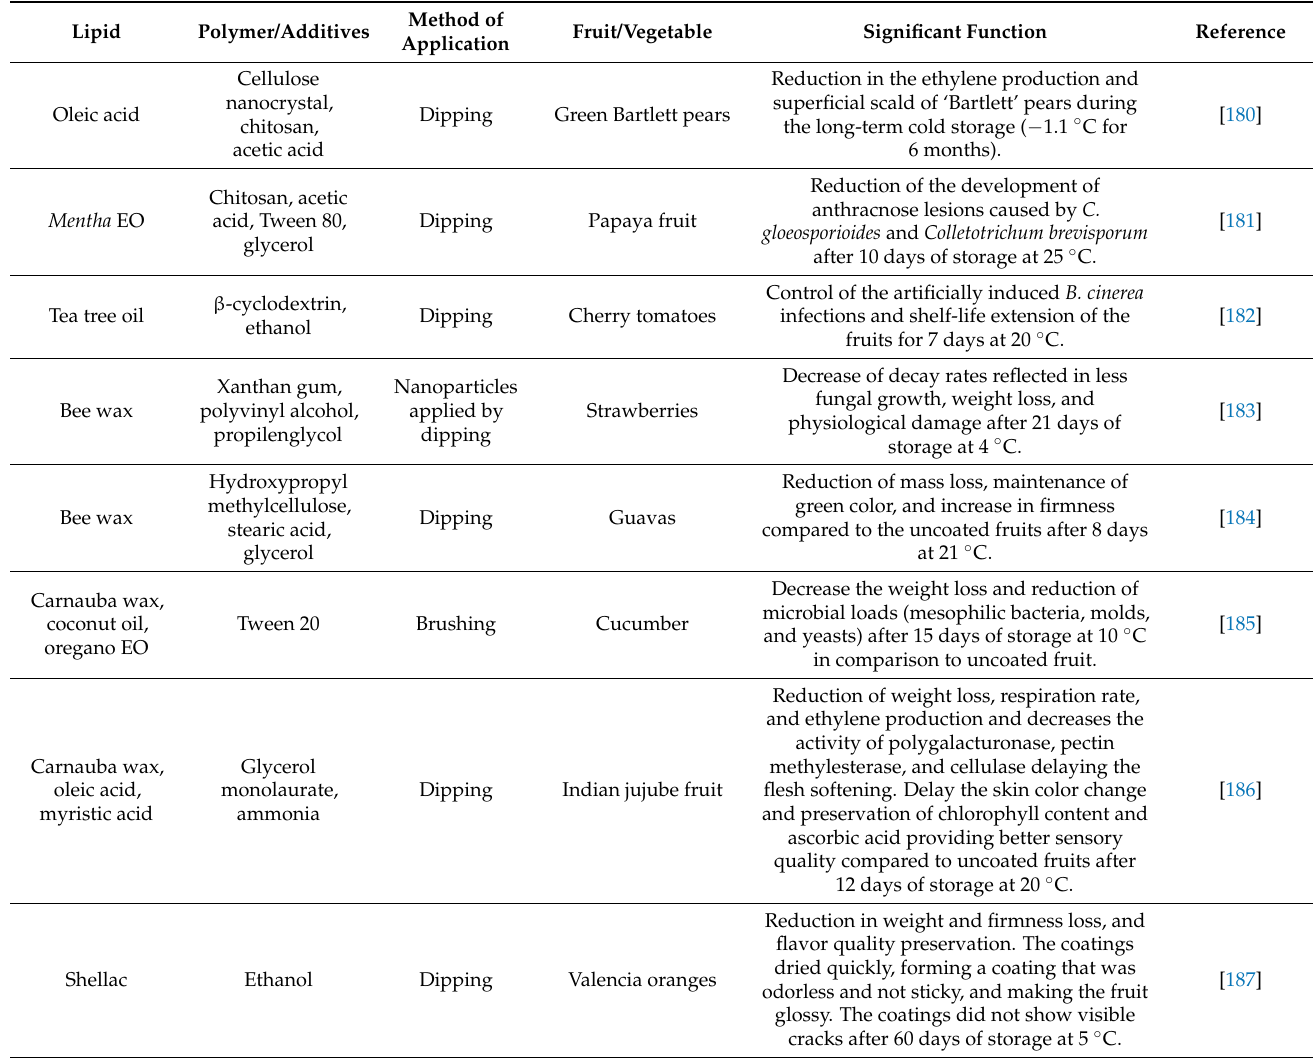
Table 3. Lipid-based coatings for different fresh fruit products with their